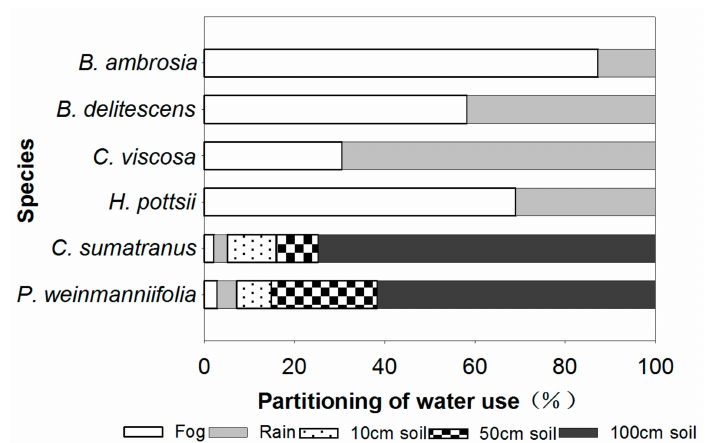
Figure 4. Partitioning of potential water sources for epiphytes and their host tree species in a tropical karst dwarf forest in the peak dry season, March 2017. Means derived from the MixSIAR mixing model (Table